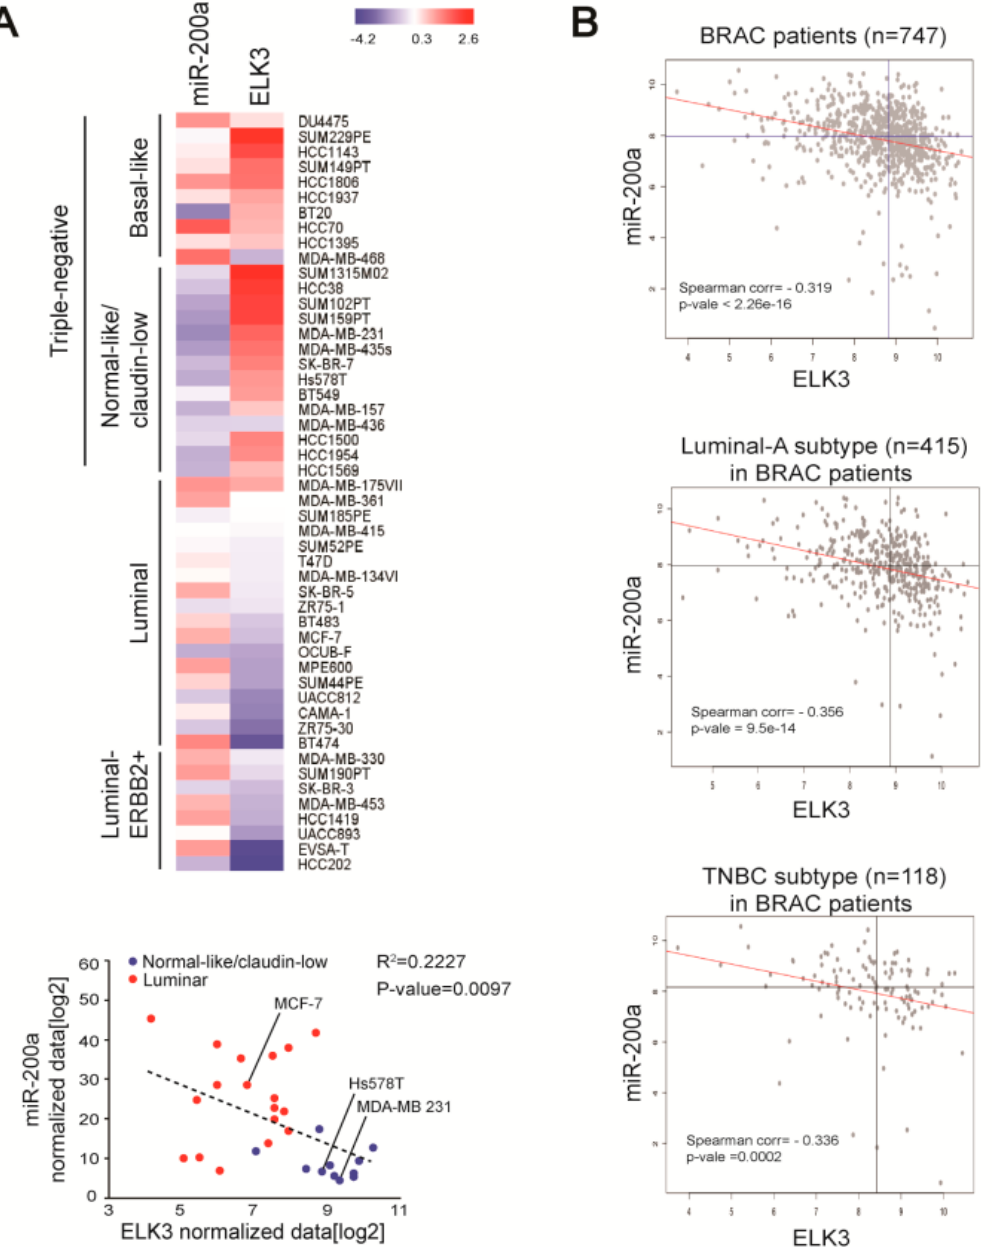
Figure 4. Expression levels of miR-200a and ELK3 mRNA are negatively correlated in breast cancer cells and patient samples. ( A ) Heat map of miR-200a and ELK3 mRNA expression in breast cancer cell lines. The blue dots indicate the normal-like / claudin-low breast cancer subtype and the red dots indicate the luminal breast cancer subtype. ( B ) Correlation between miR-200a and ELK3 mRNA expression in breast cancer patients ( n = 747). Luminal-A subtype ( n = 415) and TNBC subtype ( n = 118) samples were selected based on the receptor expression phenotype. All data were downloaded from the TCGA database.